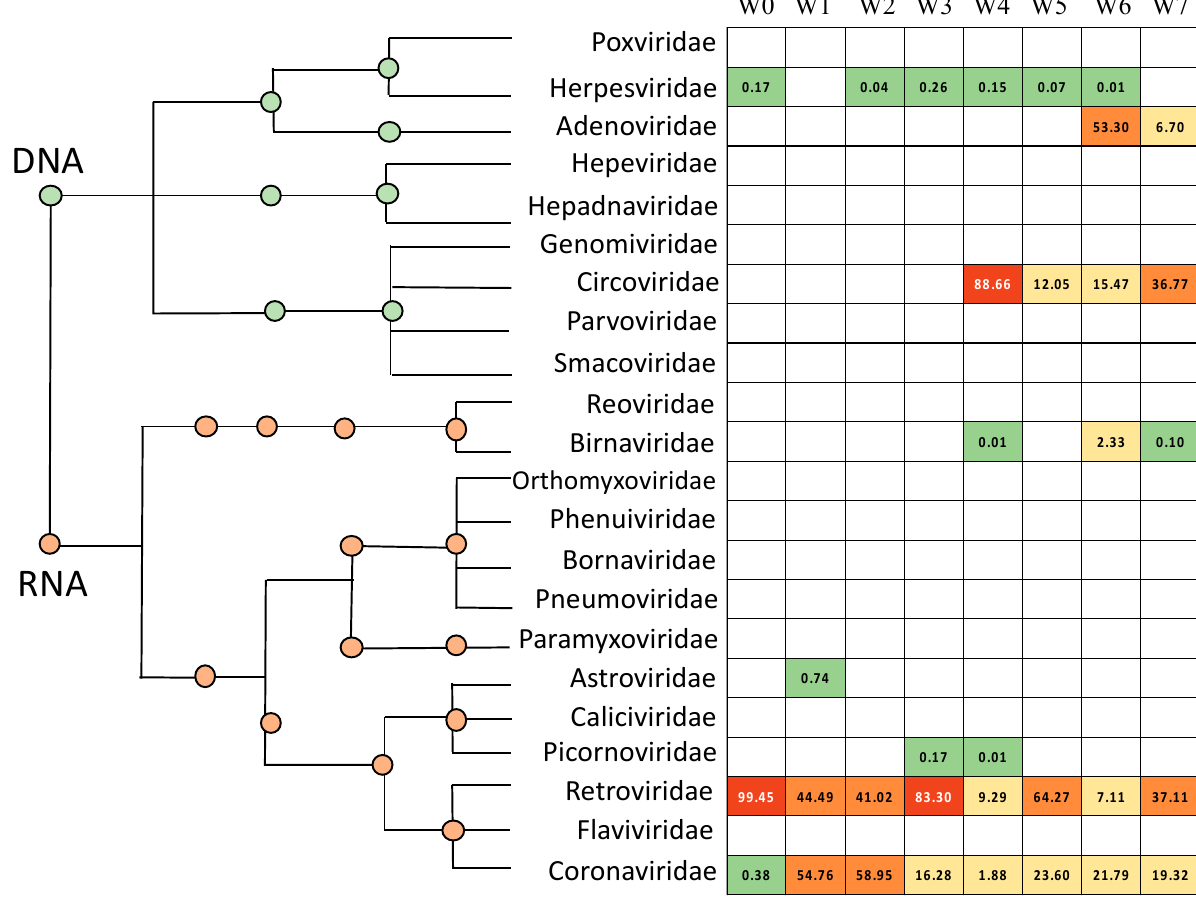
Figure 2. Heat map with phylogenetic tree representing the detection frequency of eukaryotic viral families at each individual week. Color corresponds to the range of relative abundance of each week from 0 to 100%. The sum of each column, or week, is 100%.